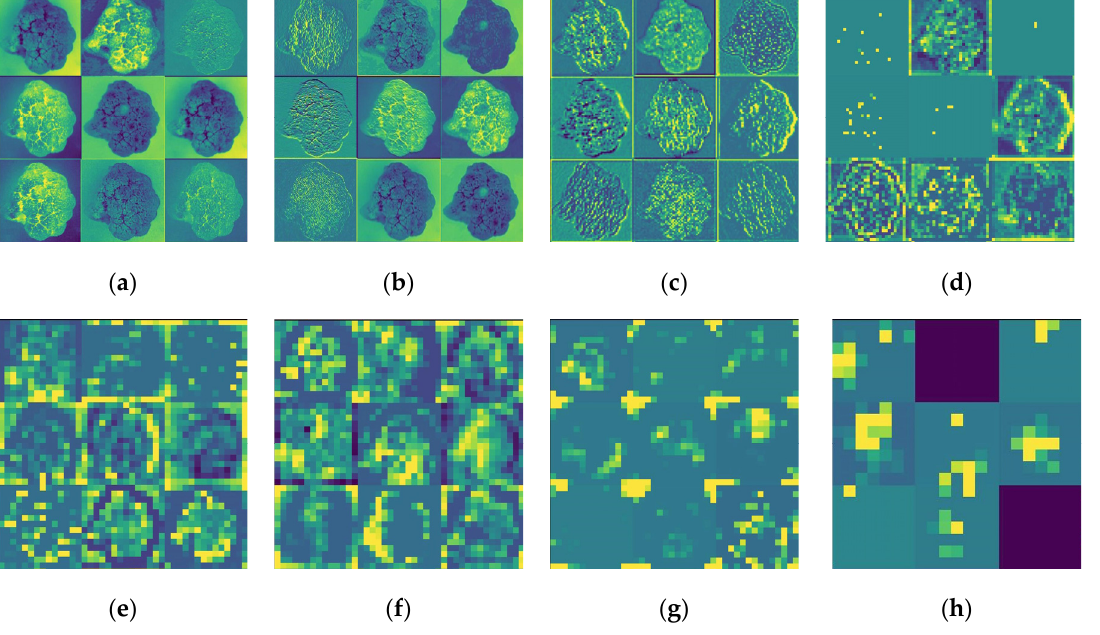
Figure 10. Feature visualization of the MobileNet model: ( a ) convolution; ( b ) depth-wise separable convolution_1; ( c ) depth-wise separable convolution_3; ( d ) depth-wise separable convolution_5; ( e ) depth-wise separable convolution_7; ( f ) depth-wise separable convolution_9; ( g ) depth-wise separable convolution_11; ( h ) depth-wise separable convolution_13.